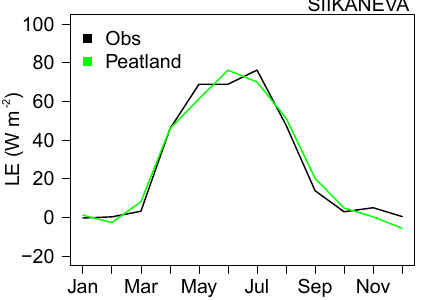
Figure 3. Observed (black) and modelled (green) turbulent latent heat flux (LE) in Wm − 2 of the peatland site of Siikaneva.